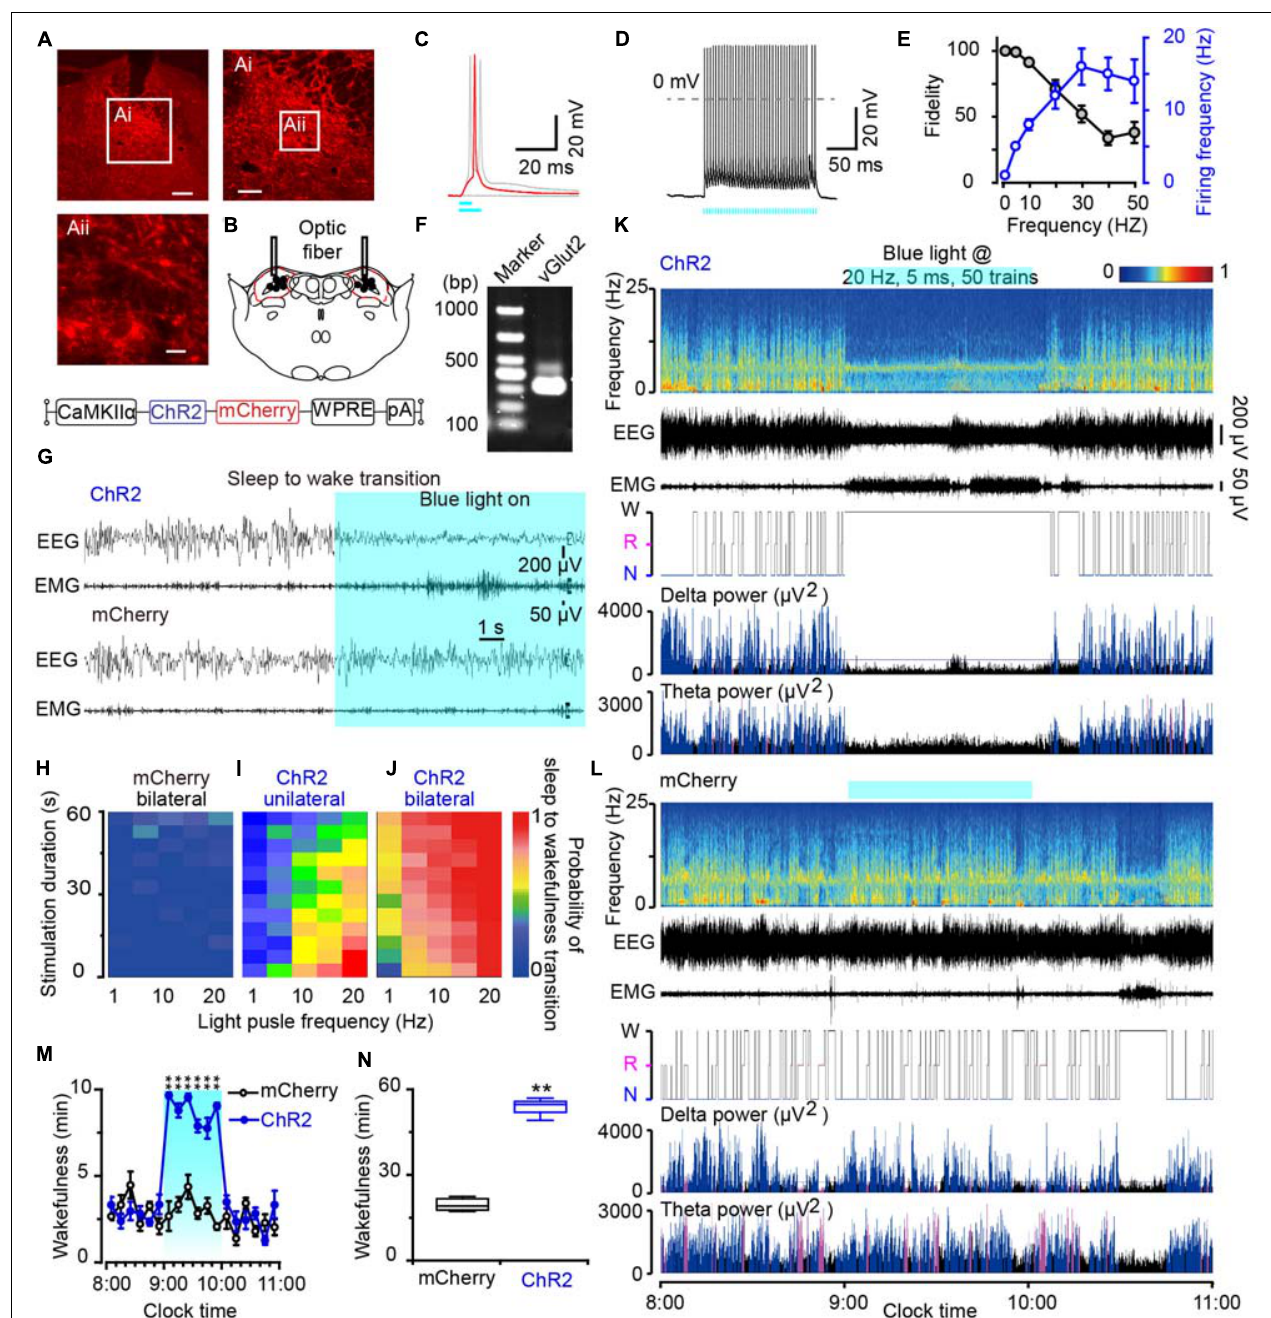
FIGURE 4 | Photostimulation of MPB glutamatergic neurons induced a rapid wakefulness response. (A) Coronal brain section with native mCherry fluorescence confirmed ChR2-mCherry was confined in the MPB. Scale bars: A = 200 µ m, Ai = 100 µ m, Aii = 20 µ m. (B) The schematic diagram showing the cannula trace and the optic fibers targeting the MPB. (C) A single action potential (red trace) evoked by 5 ms blue light pulses, and double action potentials (gray trace) evoked by > 10 ms blue light pulses from a ChR2-expressing neuron. (D) Firing traces from a ChR2-expressing MPB neuron evoked by 10 Hz (5 ms pulses) photostimulation. (E) Neuronal firing showing an effective entrainment up to 20 Hz optogenetic stimulation of MPB neurons. (F) Single-cell RT-PCR analysis of ChR2-expressing neurons in MPB indicates the band of 315 bp represents VGluT2. (G) EEG/EMG examples of the sleep to wakefulness transition following optogenetic stimulation in a rat with bilateral ChR2 (top) or mCherry (bottom) expression in MPB glutamatergic neurons. (H–J) The probability of sleep to wakefulness transition in the frequency range of 1–20 Hz in mCherry controls (H) , stimulating the MPB unilaterally (I) , and bilaterally (J) . (K,L) Typical examples of EEG power spectra, EEG, EMG, hypnogram, and relative magnitude changes in delta and theta power in a rat injected with AAV-CaMKII α -ChR2-mCherry (K) or AAV-CaMKII α -mCherry (L) bilaterally. (M,N) The time course (M) and total amount (N) of wakefulness during optogenetic stimulation. ** P < 0.01 compared with the mCherry groups ( n = 6).